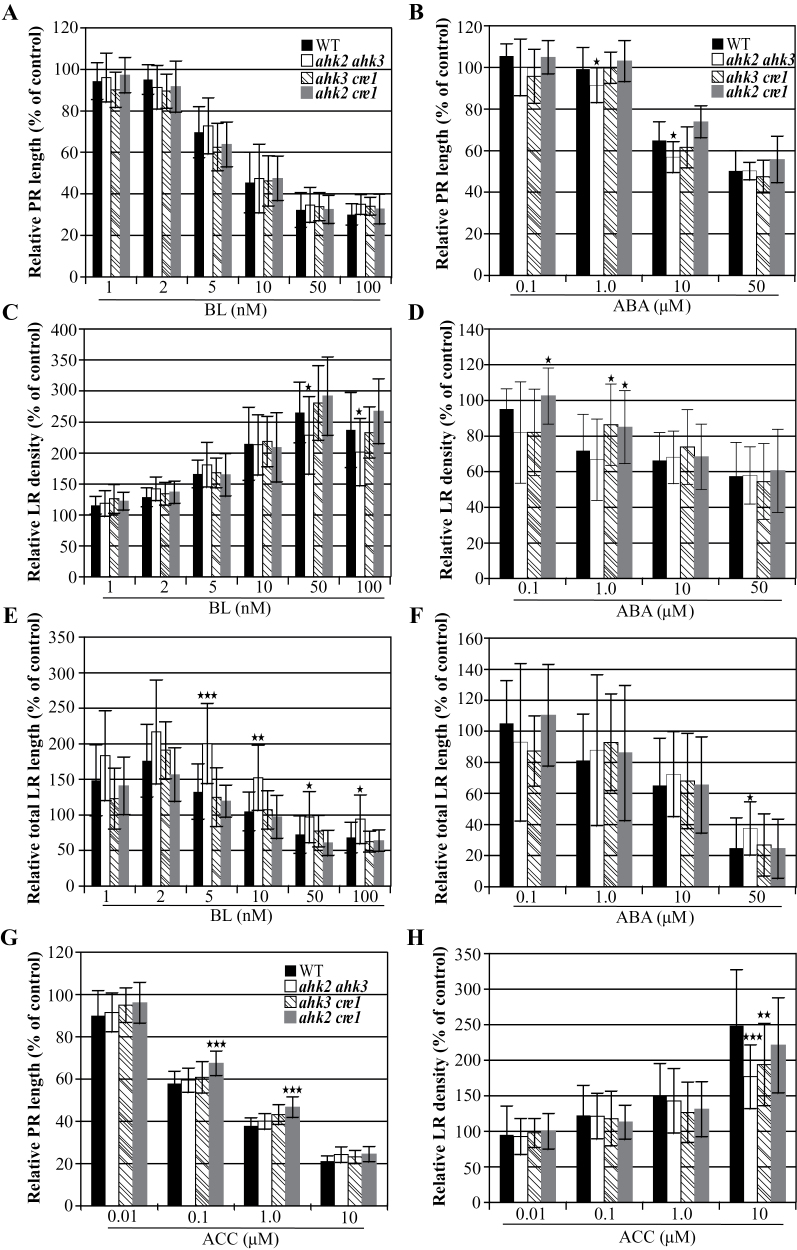
Root development of cytokinin receptor mutants in response to different plant hormones. The length of the primary root, LR density, and total length of LRs in response to BL (A, C, E), ABA (B, D, F), and ACC (G, H) were compared between the wild type and double cytokinin receptor mutants. Data are mean values ±SD. n ≥24 for primary root length and LR density; n ≥15 for total LR length. Asterisks indicate statistically significant differences from the wild type determined using Student’s t-test. * *P < 0.05; **P < 0.01; ***P < 0.001. PR, primary root; WT, wild type.